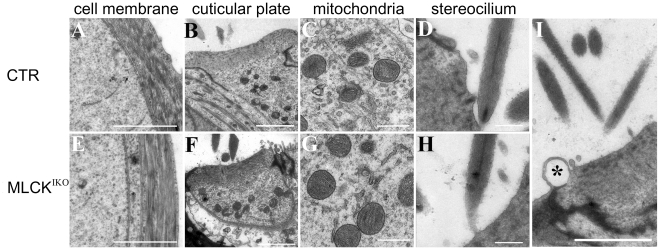
Transmission electron microscopy analyses of IHC microstructure.IHCs from 4-month-old CTR (A–D) and MLCKIKO (E–H) mice were subjected to ultrastructural analysis. “Bubbles” (indicated by asterisks) are located at the top of the cuticular plate in the mutant IHCs (I). The structures of the membranes of the IHC lateral wall (E), cuticular plate (F), mitochondria (G) and stereocilium (H) in IHCs are similar in mice of both genotypes. Scale bars: 2 µm (A, B, E, F and I) or 500 nm (C, D, G and H).